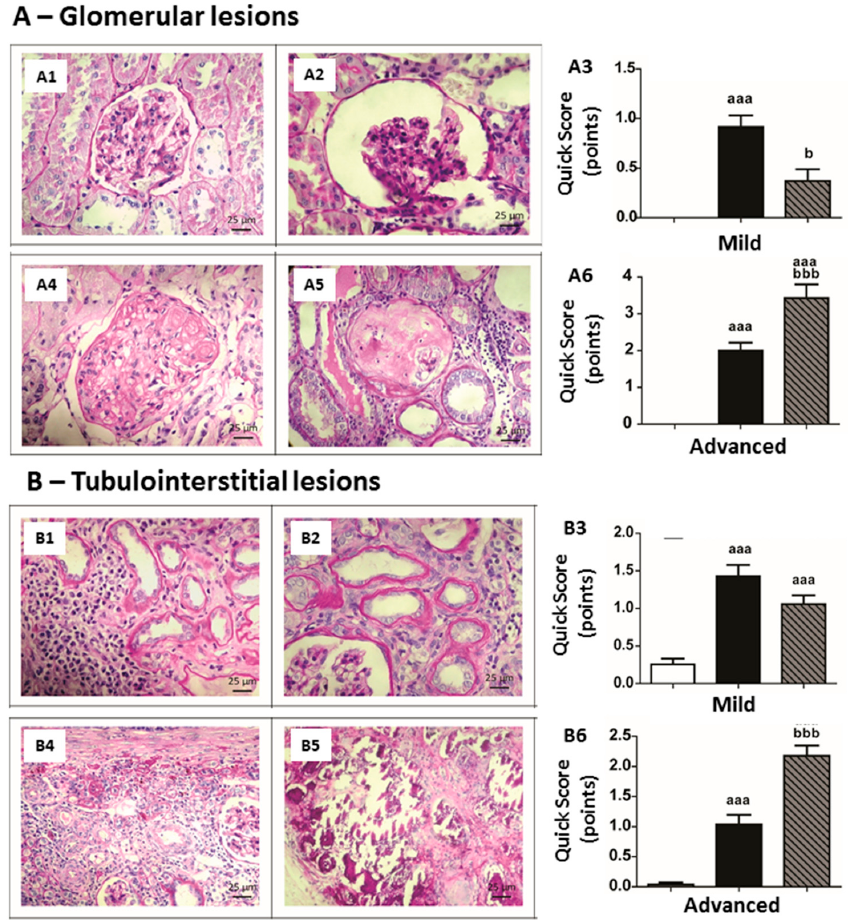
Figure 5. Kidney histopathology. Representative glomerular and tubulointerstitial lesions observed in kidneys of rat groups under study, at the final time (PAS staining, original magnification × 400).